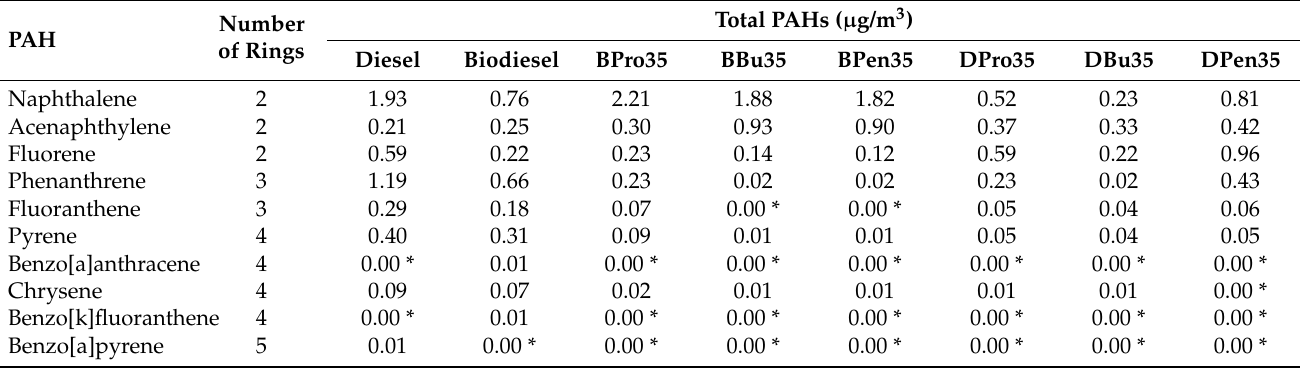
Table 4. PAH concentration in